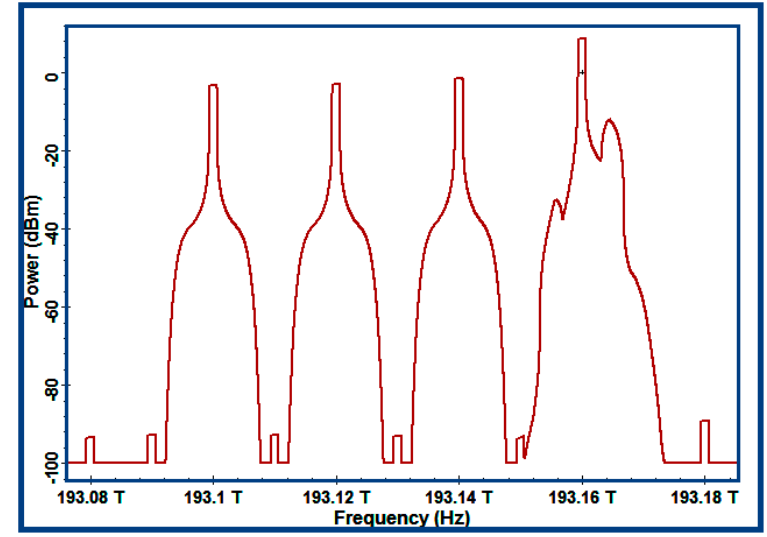
Figure 9. Optical spectrum (four wavelengths).